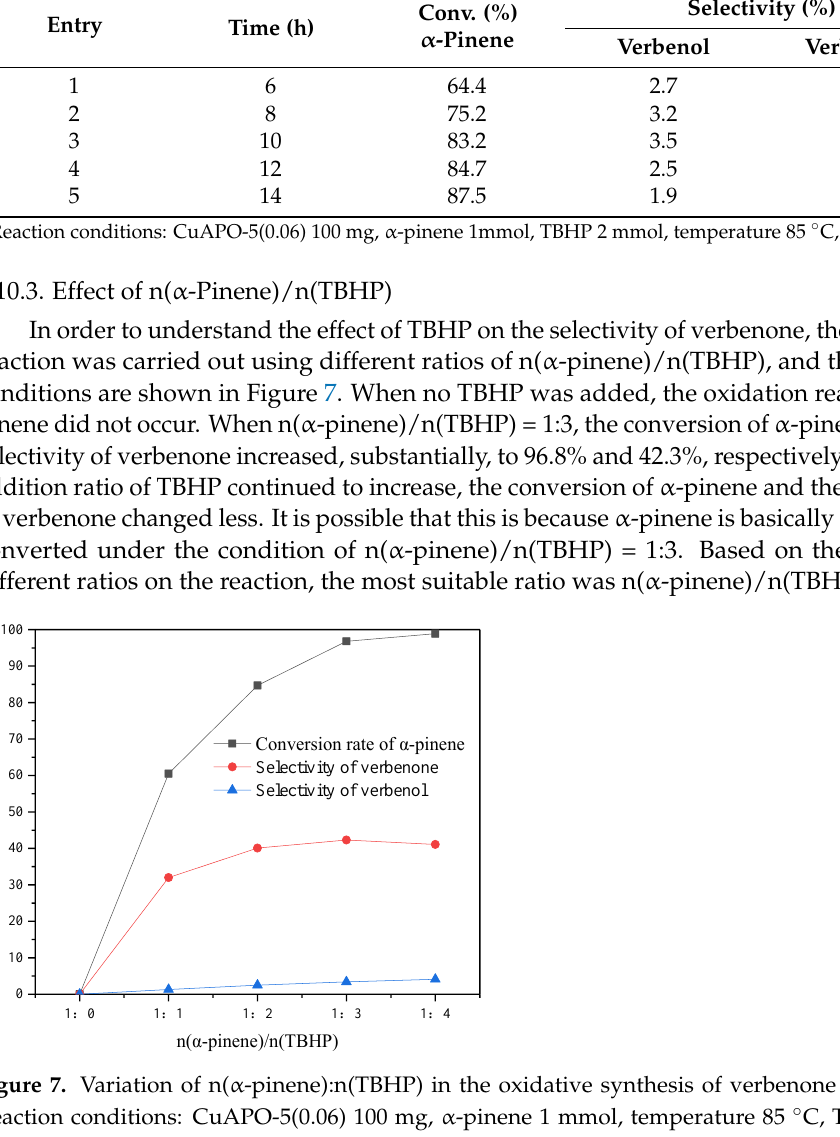
Selectivity (%) Conv. (%) α -Pinene Verbenol Verbenone